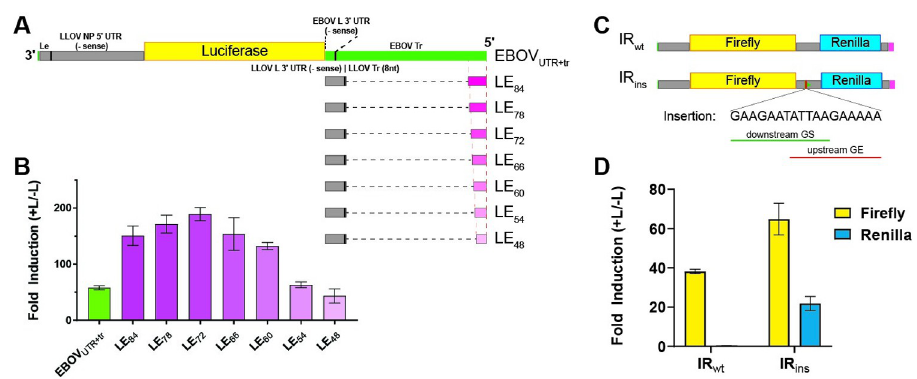
Fig 1. Complementation assays identify sequences that facilitate LLOV transcription and replication. (A) Schematic of LLOV minigenomes with EBOV noncoding region (negative sense L gene 3 ˈ UTR) and trailer (top) or hybrid 5 ˈ genome ends consisting of the LLOV L gene 3 ˈ UTR and trailer complemented with short terminal sequences from the EBOV trailer, designated LE X where X represents the number of added terminal nucleotides from EBOV. Le, leader; NP, nucleoprotein; L, polymerase; Tr, trailer. (B) Luciferase-based minigenome assays comparing the 3L5E [9] and chimeric 3L5LE X minigenomes. Mean fold induction of firefly luciferase activity over the negative control (minus L) and normalized to ß-galactosidase activity (transfection control) with standard deviation is shown. (C) Schematic of bicistronic 3L5LE 72 minigenomes containing firefly and renilla luciferase reporters separated by either the wild-type LLOV VP24-L intergenic region (IR wt ) or the same intergenic region with an inserted gene border (IR ins ) consisting of overlapping LLOV gene end (GE, red bar) and gene start (GS, green triangle) signals. (D) Luciferase-based minigenome assays comparing the bicistronic minigenomes. Mean fold induction of firefly and renilla luciferase activities over the negative controls (minus L) and normalized to ß-galactosidase activity (transfection control) with standard deviation is